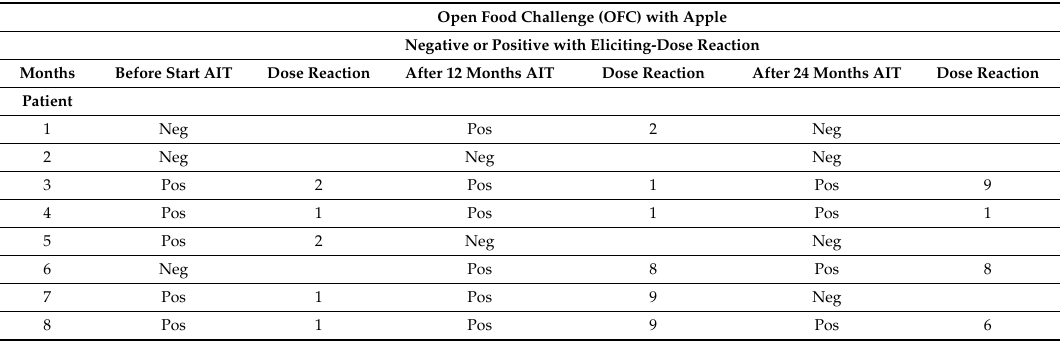
Table 2. Challenge results of eliciting-dose reaction to open apple challenge over time. Open Food Challenge (OFC) with Apple Negative or Positive with Eliciting-Dose